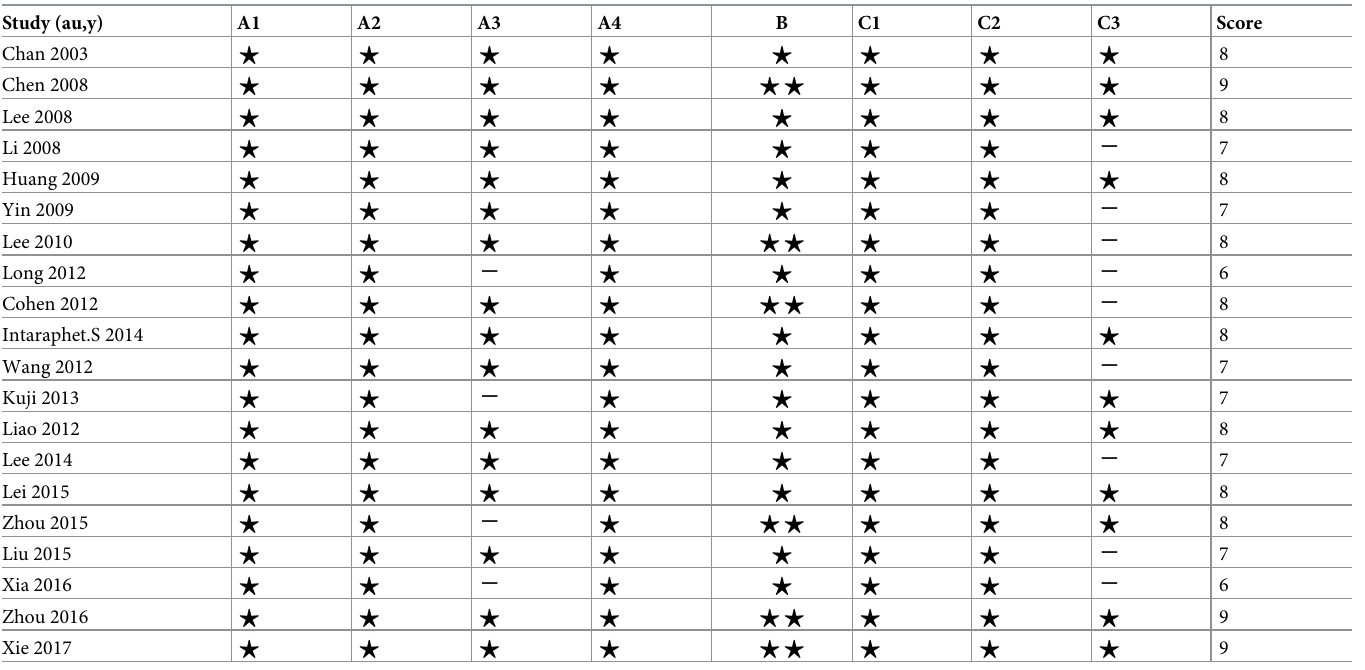
Table 2. Results of quality assessment using the Newcastle-Ottawa Scale for cohort